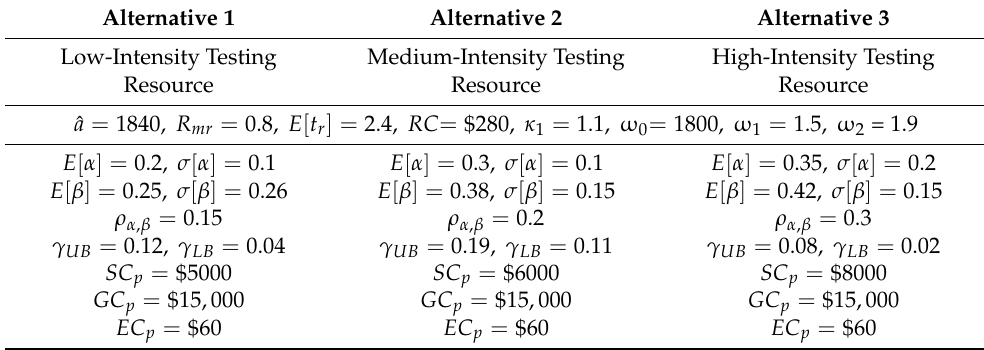
Table 4. Related debugging costs and parameter estimation of the three alternatives.